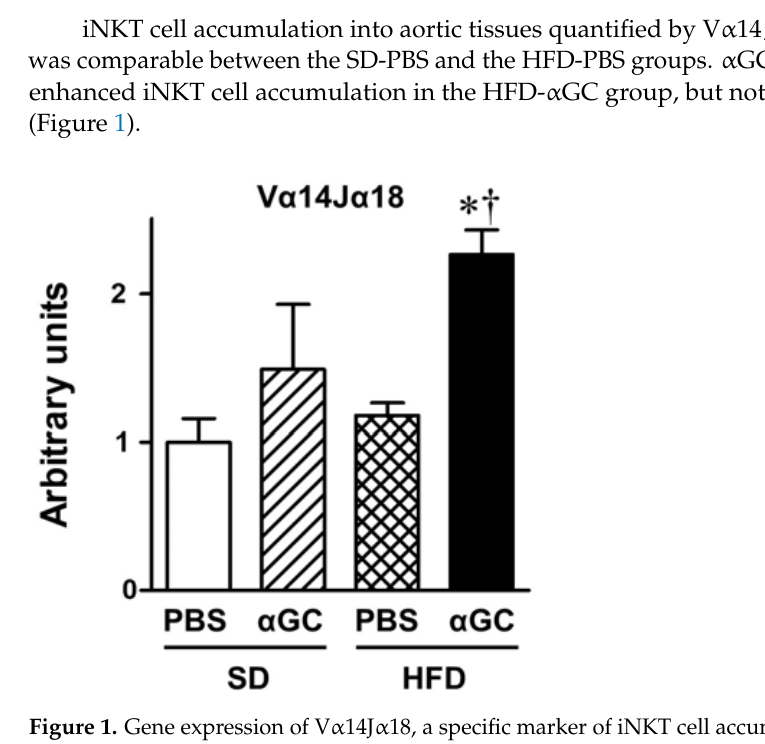
Figure 1. Gene expression of V α 14J α 18, a specific marker of iNKT cell accumulation, in aortic tissues from four groups of SD-PBS (n = 6), SD- α GC (n = 7), HFD-PBS (n = 21), and HFD- α GC (n = 21) mice. * p < 0.01 vs. SD-PBS, † p < 0.01 vs. HFD-PBS by ANOVA. All data are expressed as means ± S.E. Fatty streak lesions were observed in brachiocephalic artery from the SD-PBS group